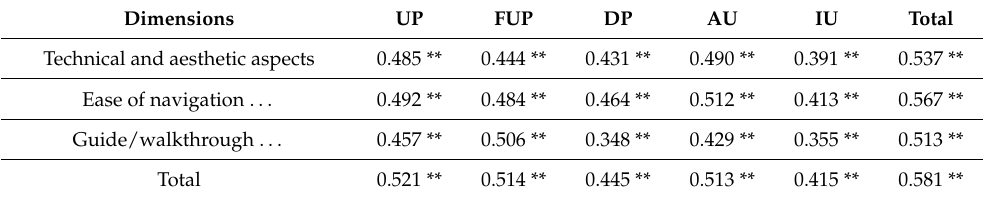
Table 8. Correlations in the variables “evaluation” and “degree of acceptance of the technology”.